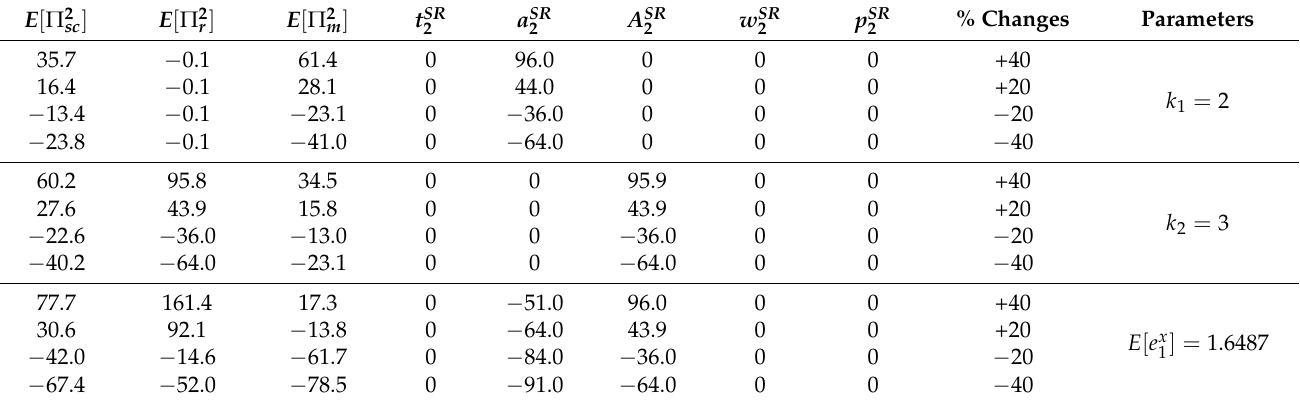
Table 13. The results of the sensitivity analysis in the SG-RL for the second model.